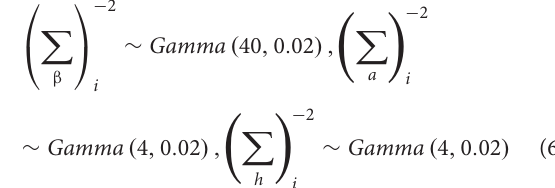
Frontiers in Environmental Science |